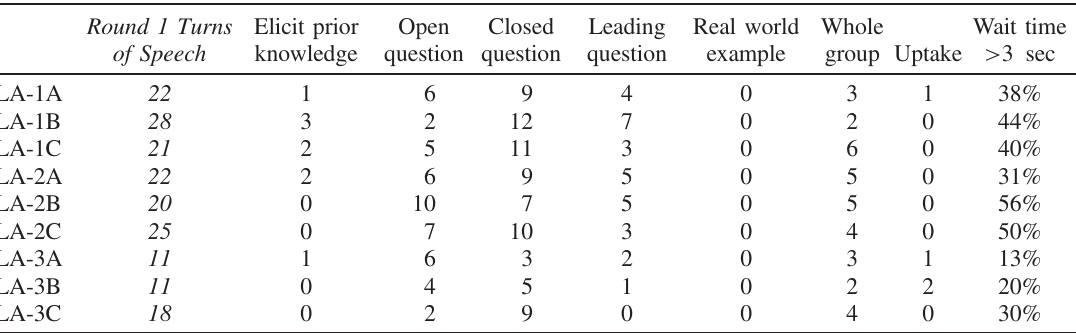
TABLE III. Frequency of pedagogical skill use: Round 1. Round 1 Turns of